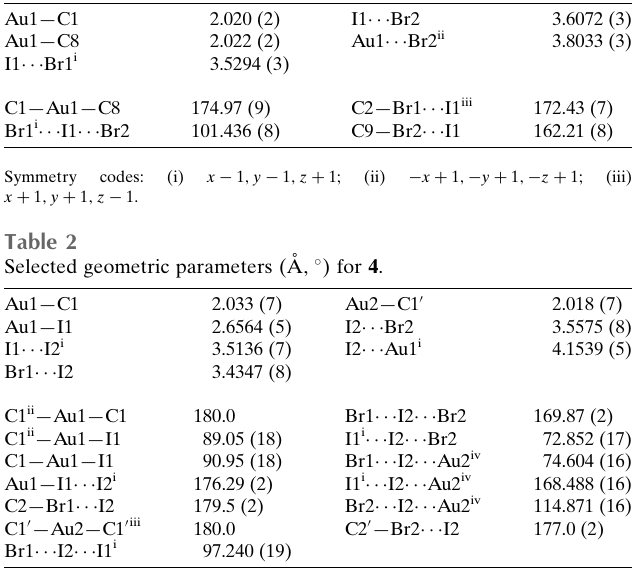
Table 1 Selected geometric parameters (A˚ , (cid:3) ) for 3